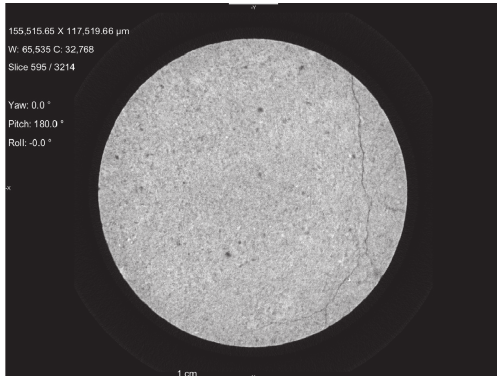
Figure 3: CT slice of a sample.